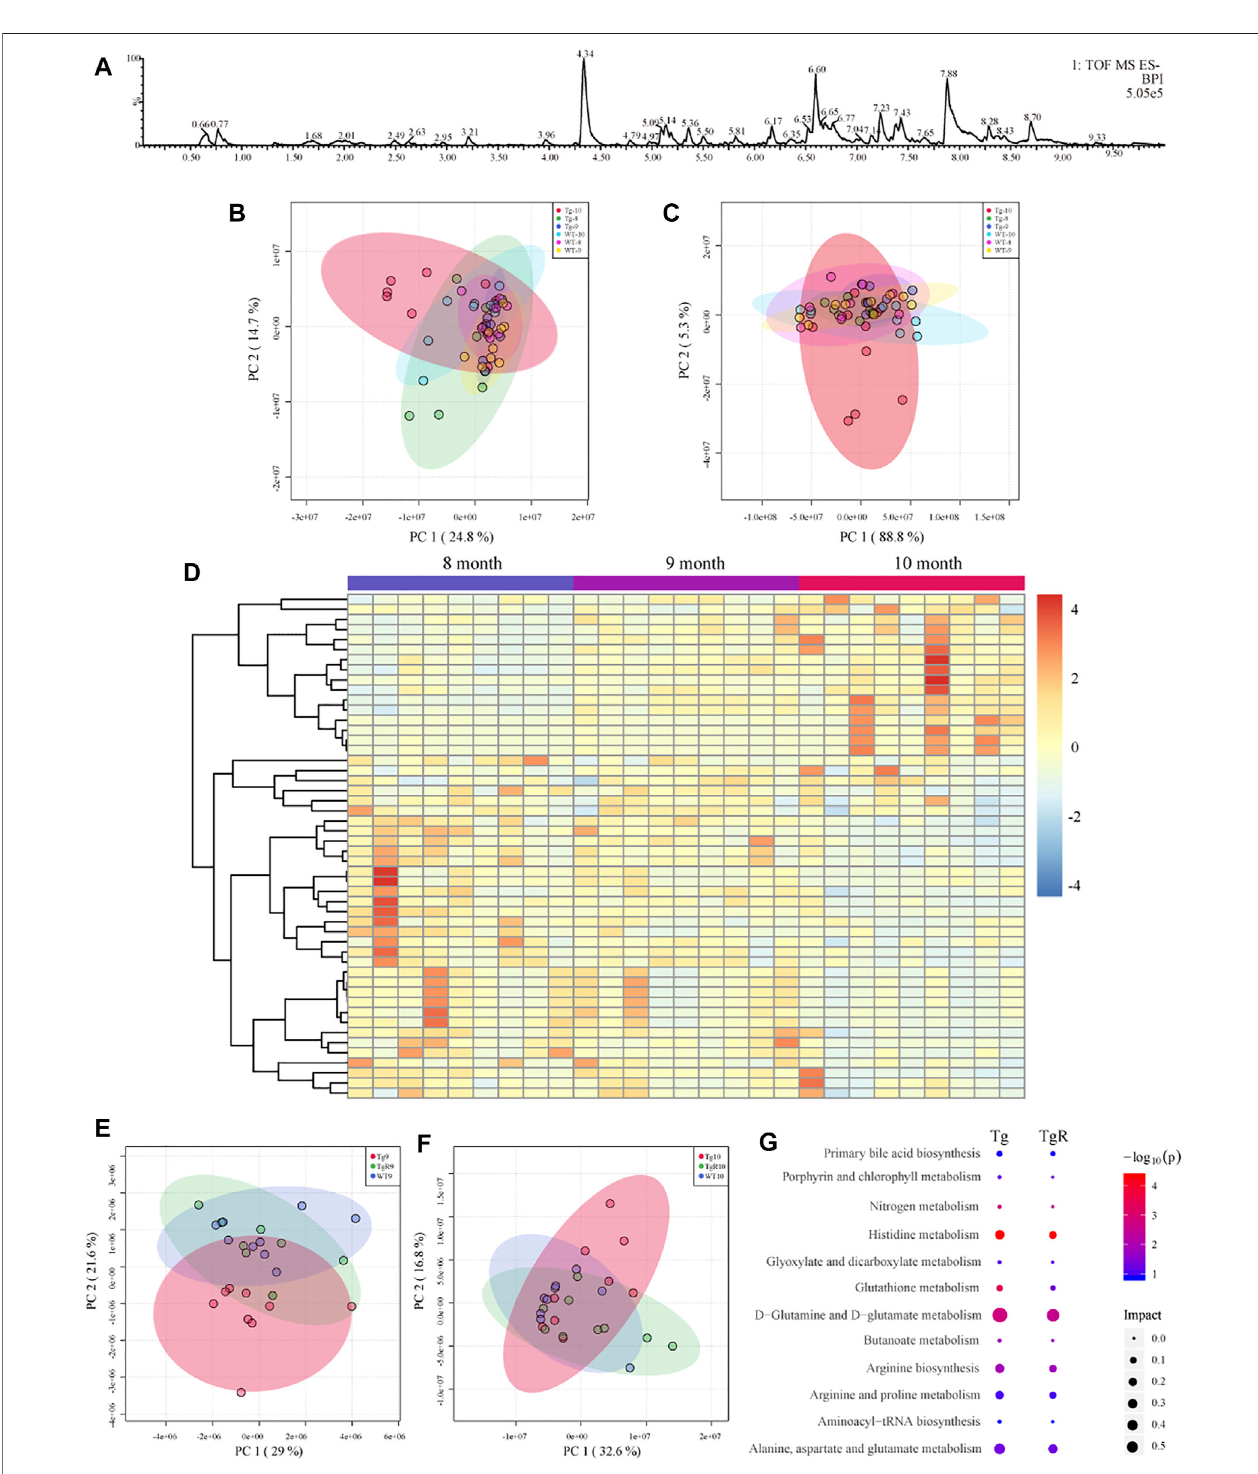
FIGURE 6 | Fecal metabolomics pro fi le of Tg mice (A – D) . (A) Representative base peak ion chromatogram (BPI) of fecal metabolites from Tg sample. PCA score plotsinpositive (B) andnegative (C) ionmode. (D) Heatmapshowingthetrendofmetabolomicpro fi linginalltheTggroups.Effectsofrhubarbonthefecalmetabolomics ofADmodel (E,F) .PCAscoreplotsbasedonfecalmetabolicpro fi les underthenegativeionmode.TgRmicereceivedrhubarbintervention30 days (E) and 60 days (F) . (G) PathwayenrichmentofdifferentmetabolitesinWTandTgmiceandthemetabolitesrecoveredafterrhubarbadministration.Thesizeofthenoderepresentsthe path impact value and the colour represents the − log 10 ( p ) value of the pathway.